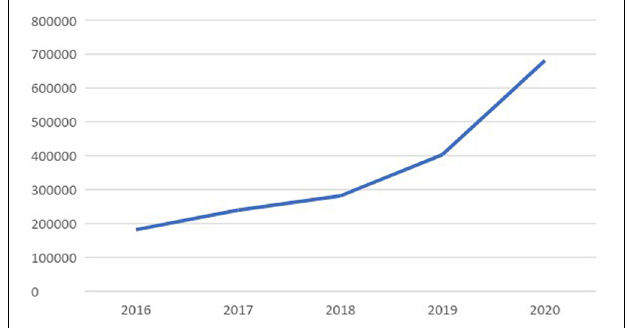
FIGURE 1 | Number of tweets over time.